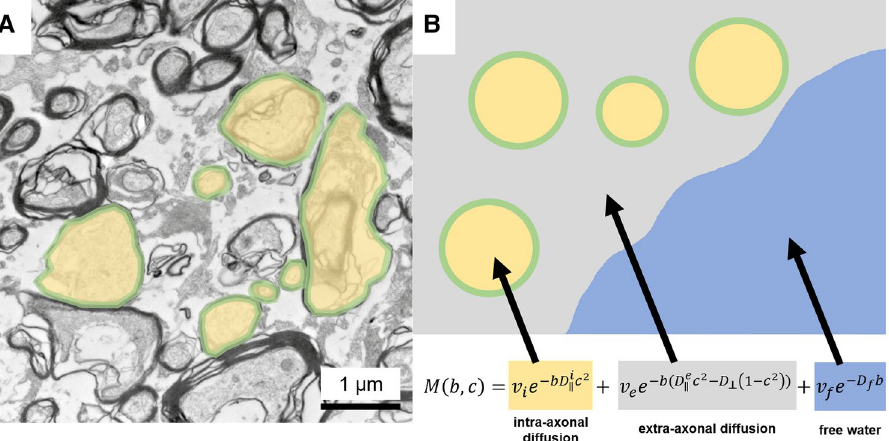
Figure 1. Diffusion Microstructure Imaging (DMI). White-matter electron microscopic (60 nm ultrathin sections, ( A )) and schematic representation ( B ). In a three-compartment diffusion microstructure model,